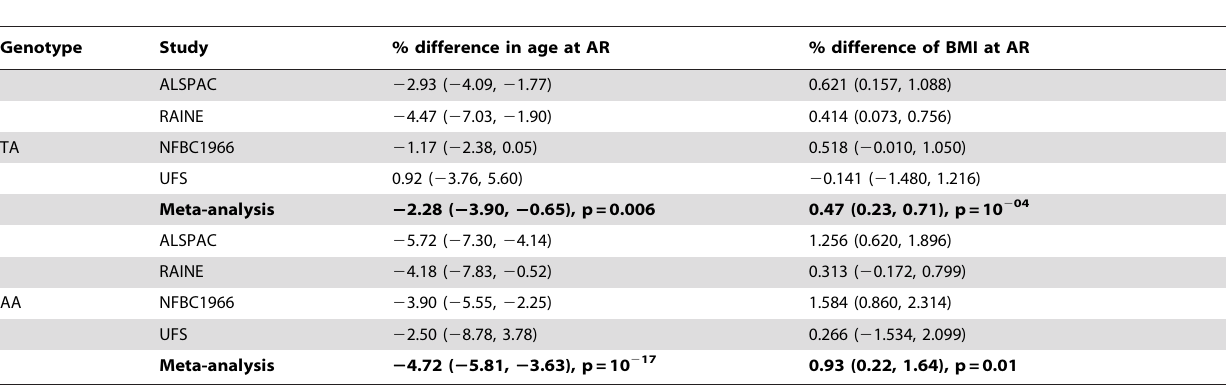
Table 3. Differences in age and body mass index (BMI) at adiposity rebound (AR) between FTO genotype groups with 95% confidence interval (95%